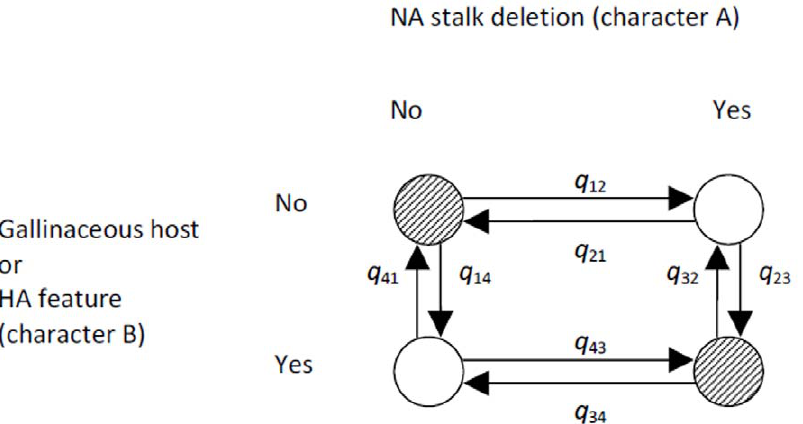
Figure 5. Illustration of all possible combinations of two binary characters (A and B) and the transition rates between these combinations. The model fits rates for the transitions per infinitely small time interval and therefore allows the change of only one state at a time (i.e. no rates are fitted for diagonal transitions). The shaded character combinations are expected to dominate if characters A and B are positively correlated. This positive correlation is created by transition rates if D Q = q 21 + q 23 + q 41 + q 43 2 ( q 12 + q 14 + q 32 + q 34 ) . 0.